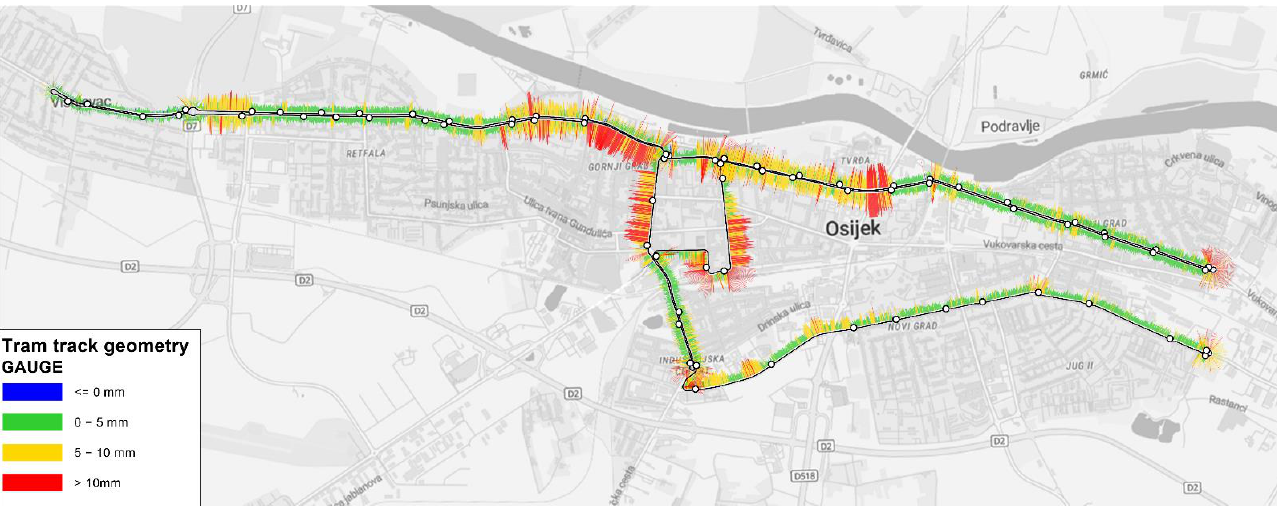
Figure 4. Measured track geometry irregularities histograms.